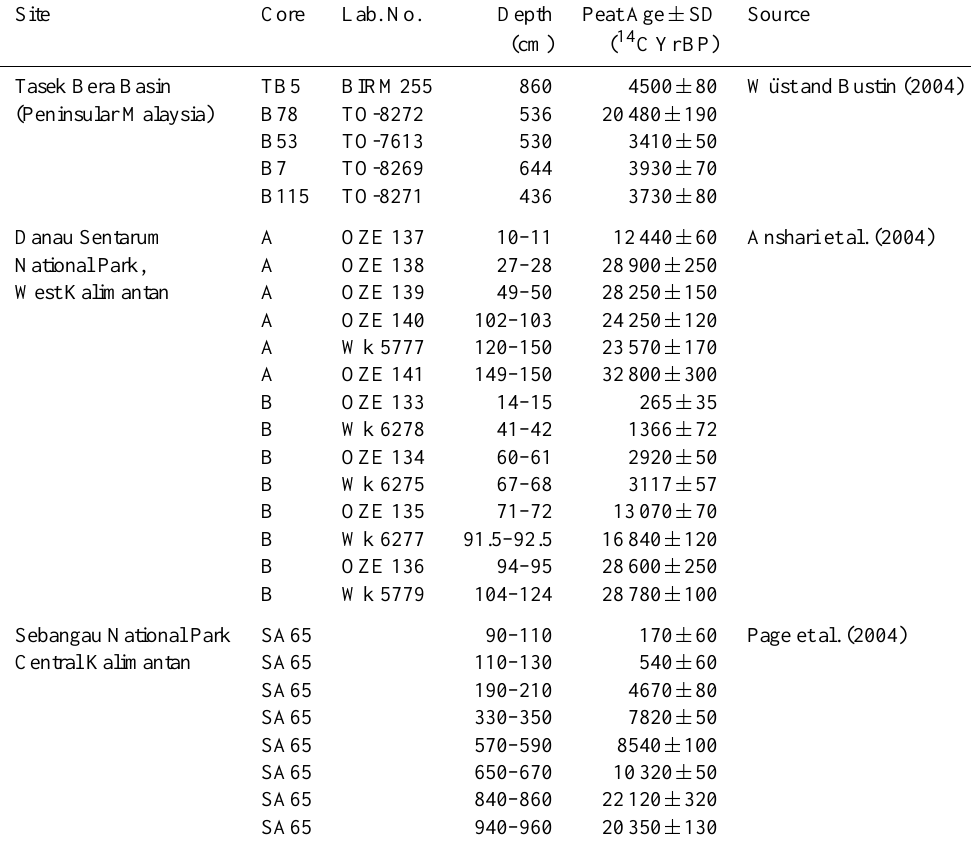
Table 3. Selected Radio Carbon Dates of Peats from Kalimantan and Peninsular Malaysia.